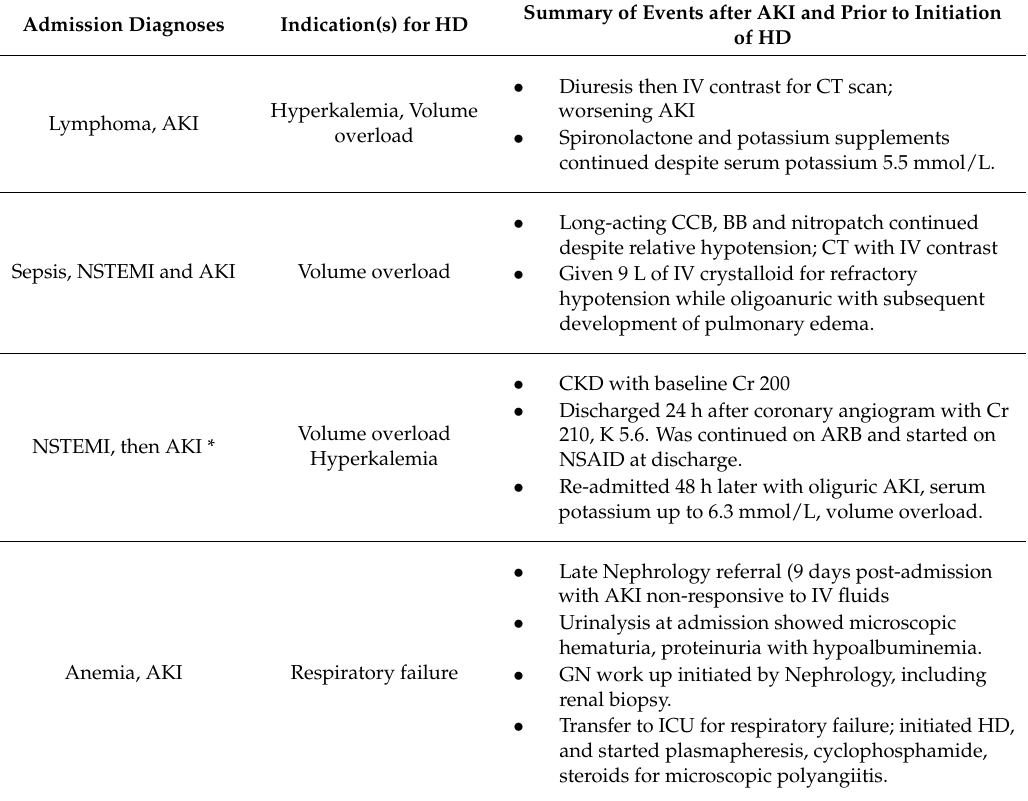
Table 5. Selected cases that highlight safety lapses in patients requiring hemodialysis after Acute Kidney